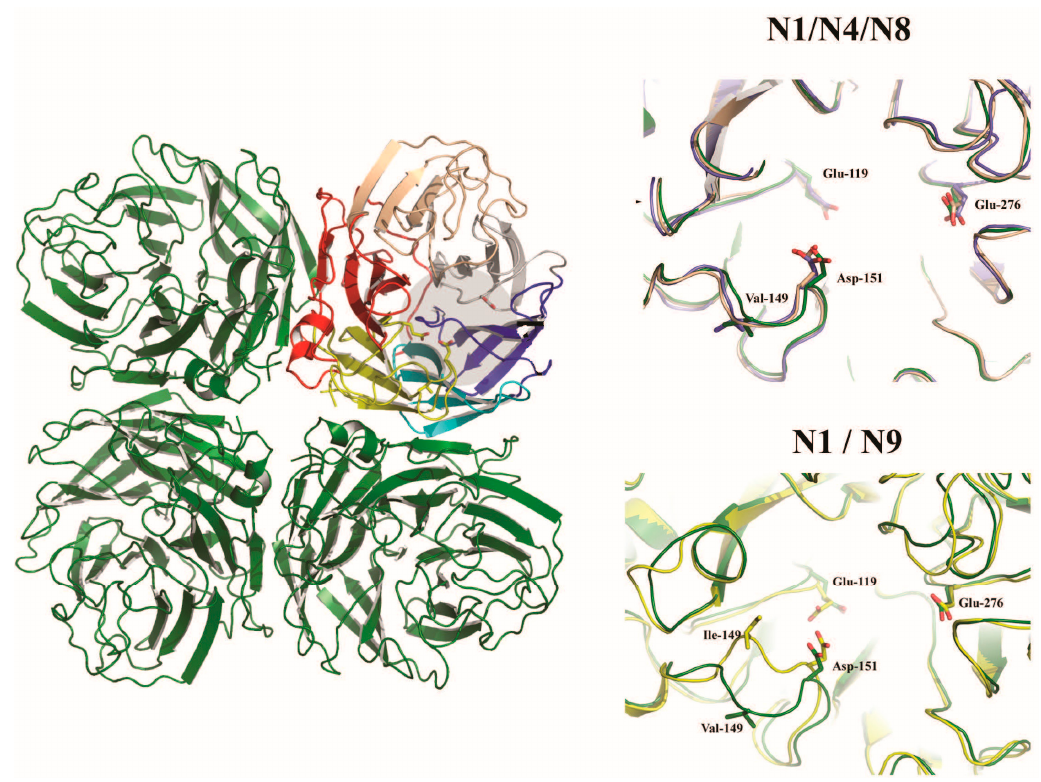
Figure 3. Influenza A virus neuraminidase homotetramer. The catalytic site is shaded in gray on the colored monomer in the left panel. The right panels illustrate subtype differences in the catalytic sites by superimposing the subtypes shown (N4 and N8—top panel; and N2 and N9—lower panel) onto the N1 subtype (shown in green).